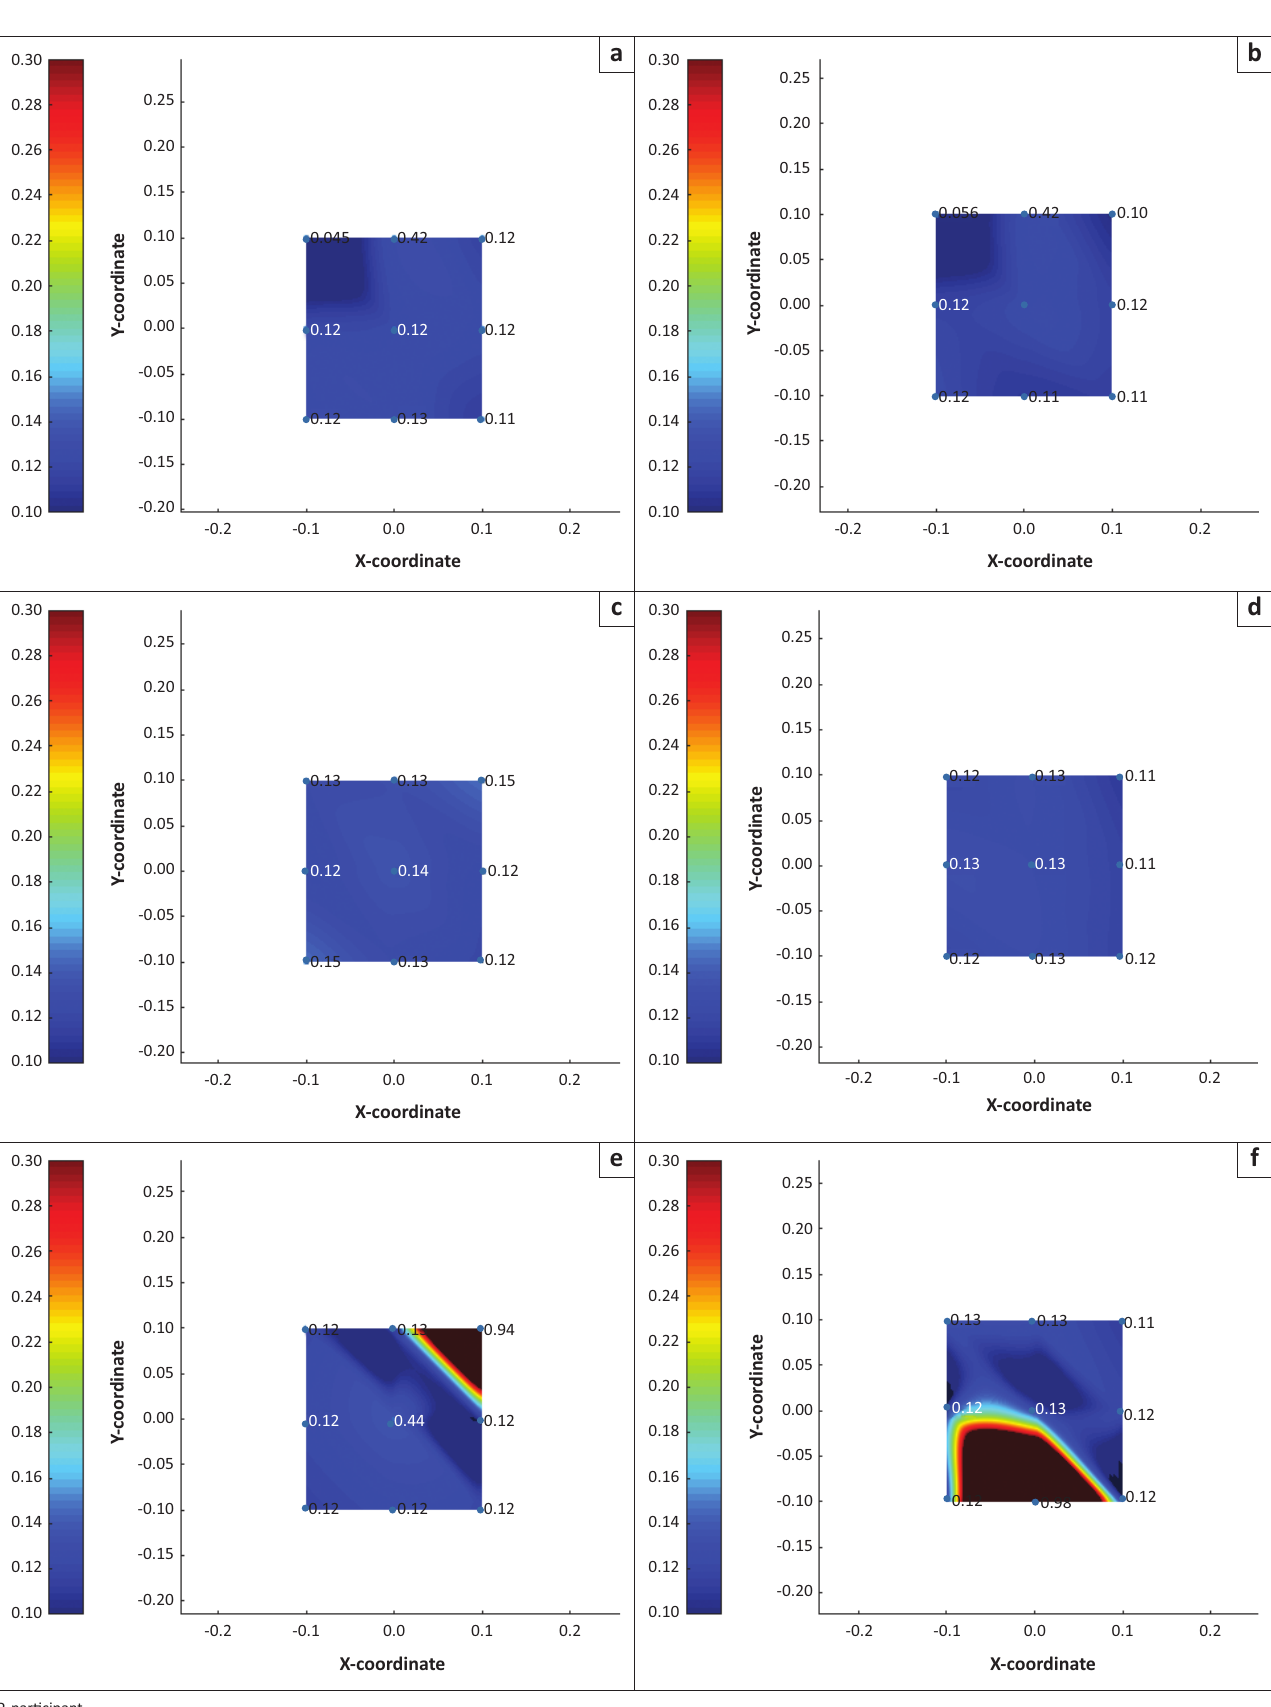
P, participant. FIGURE 4: Pseudo-3D maps of oscillatory threshold for test (t) and retest (rt) macular field tests for three participants (P16, P20 and P27) chosen from the sample ( n = 26) to illustrate eyes with the smallest, average (normal) and largest oscillatory thresholds. (a) P16 test, (b) P16 retest, (c) P20 test, (d) P20 retest, (e) P27 test and (f) P27